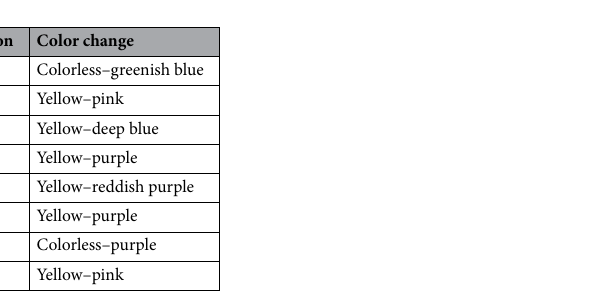
Figure 3. Response optimization obtained from Minitab by minimizing the initial positivity (Ini_post) and TTR (TTR_post) of positive reactions, and minimizing the Nmax (Color Delta) of negative reactions with the desirability of 0.989. To achieve the optimal response the final model was primer at onefold concentration, Bst at 0.4 U/μL (equivalent to 50%), magnesium sulfate at 8 mM, betaine at 400 mM, primers targeting the N and Orf1ab sequence, and temperature of 67 °C.